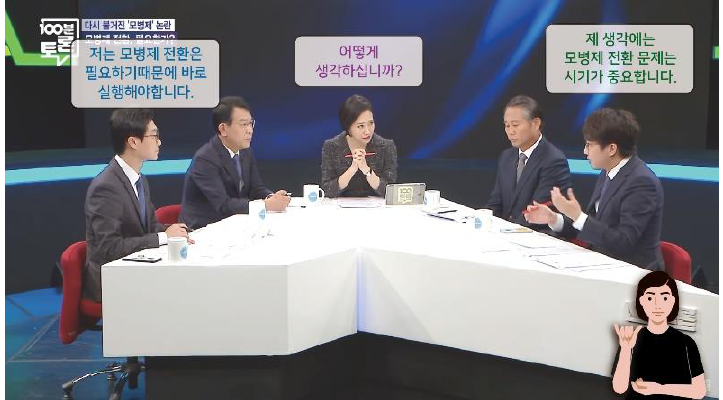
Figure 24. Proposed layout design of information delivery components for discussion type broadcasts.